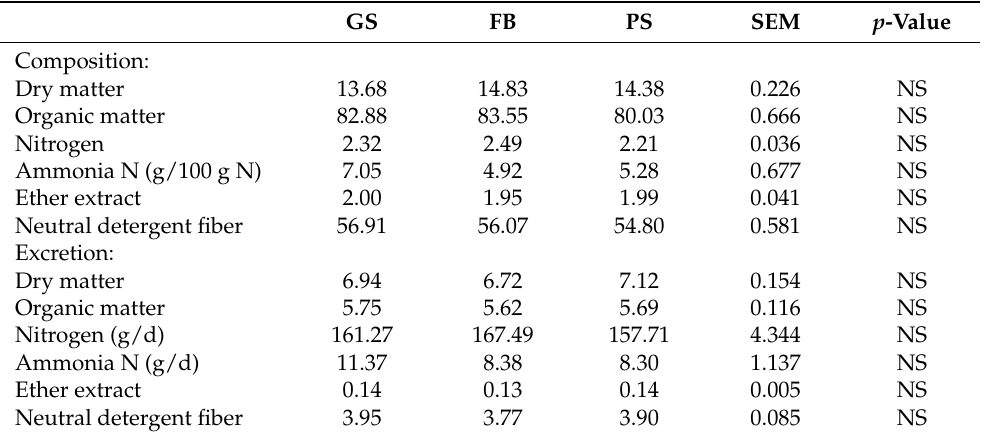
Table 8. Composition of feces (% dry matter basis) and feces excretion (kg/day, dry matter basis) by